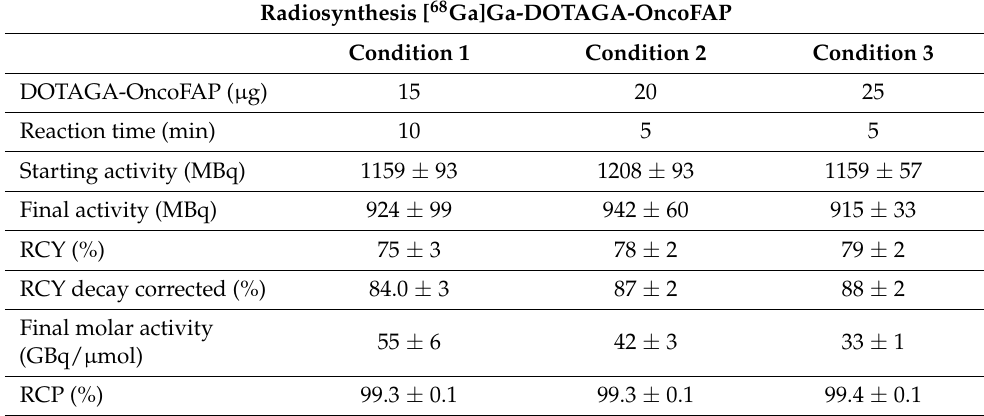
Table 3. Different synthetic conditions used for [ 68 Ga]Ga-DOTAGA-OncoFAP.